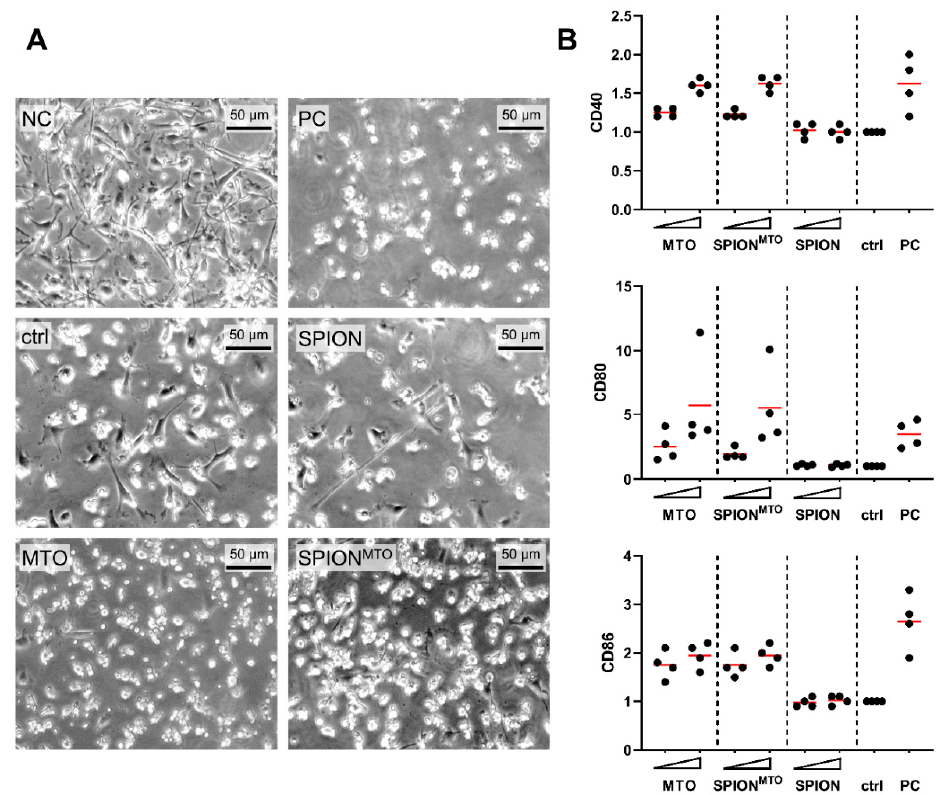
Figure 5. Maturation of dendritic cells after co-incubation with supernatants of HT-29 cells. Supernatants of HT-29 cells which had been treated for 72 h with SPION, MTO and SPION MTO (MTO concentration 1.0 μ M and 5.0 μ M and corresponding SPION concentrations, see Table 2) were co-incubated with monocyte-derived immature dendritic cells (iDC) from four healthy donors. After 24 h of co-incubation, the expression of the activation markers CD40, CD80 and CD86 were analyzed using flow cytometry. Untreated iDC in HT-29 medium (NC), matured DC (mDC) in HT-29 medium (PC) and iDCs in supernatant from H 2 O treated HT-29 cells (ctrl) served as controls. ( A ) Light microscopic pictures of DCs incubated with supernatant of HT-29 cells treated with 1 μ M MTO and corresponding concentrations of SPION and SPION MTO . ( B ) Each donor was tested at least as duplicate and each mean value was normalized to the untreated control. Every dot represents the mean value of one donor, the red line the mean of all donors.